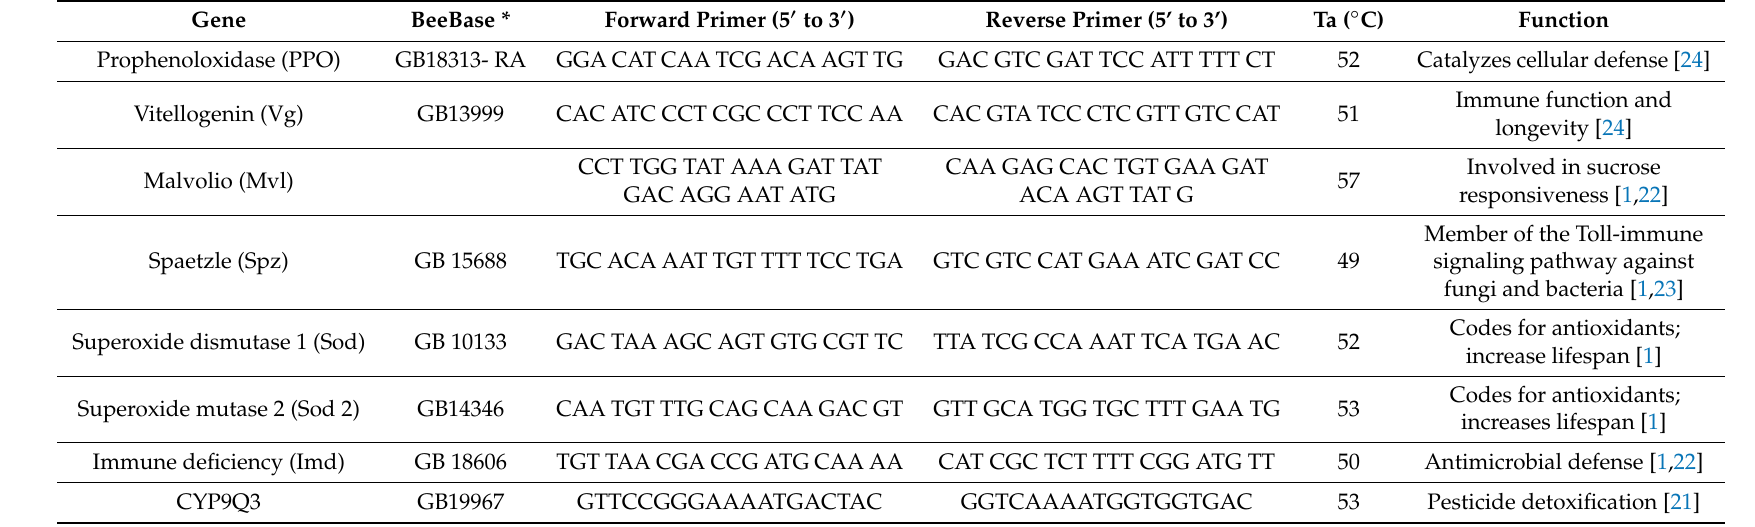
Table 1. Primers used for quantitative PCR of honey bee immune-link